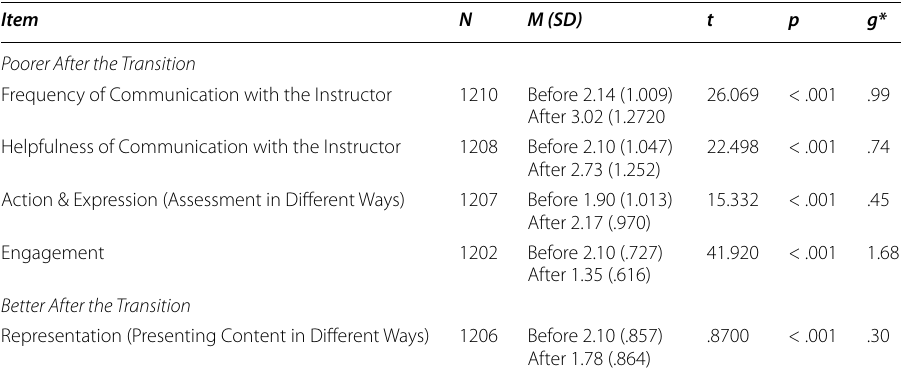
Table 1 Significant changes in reported quality of instruction before and after the shift to remote